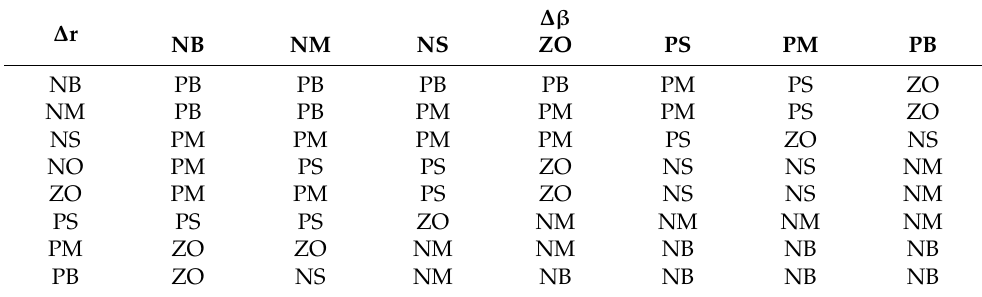
Table 2. Fuzzy control rule